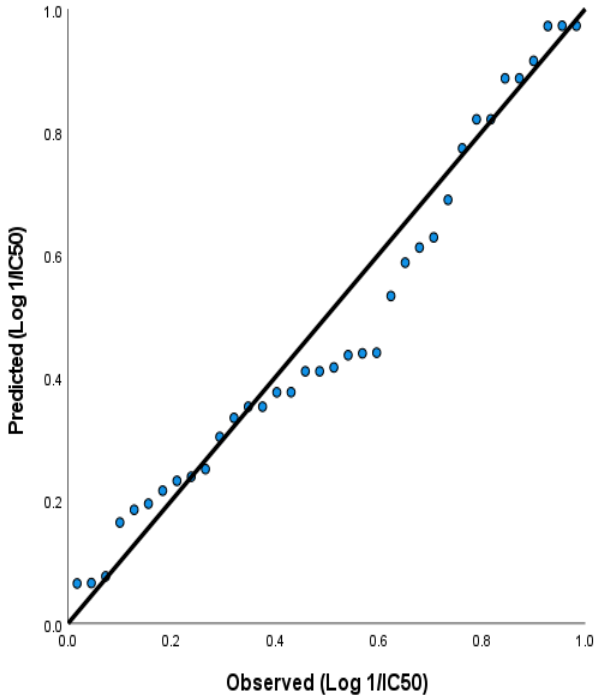
Figure 20. The third QSAR model is obtained by following regression equation Log1/IC50 = 0.56 − 0.03488 E HOMO − 0.395 χ , eV + 0.213 V, eV + 0.315 ω , eV + 1.318 N, eV + 0.1391 logP + 0.56 − 0.03488 E HOMO − 0.395 χ, eV + 0.213 V,eV + 0.315 ω,eV + 1.318 N, eV + 0.1391 logP + 0.4516 n rotb + 0.634 logD 0.4516 n rotb + 0.634 logD 7.4 . 7.4